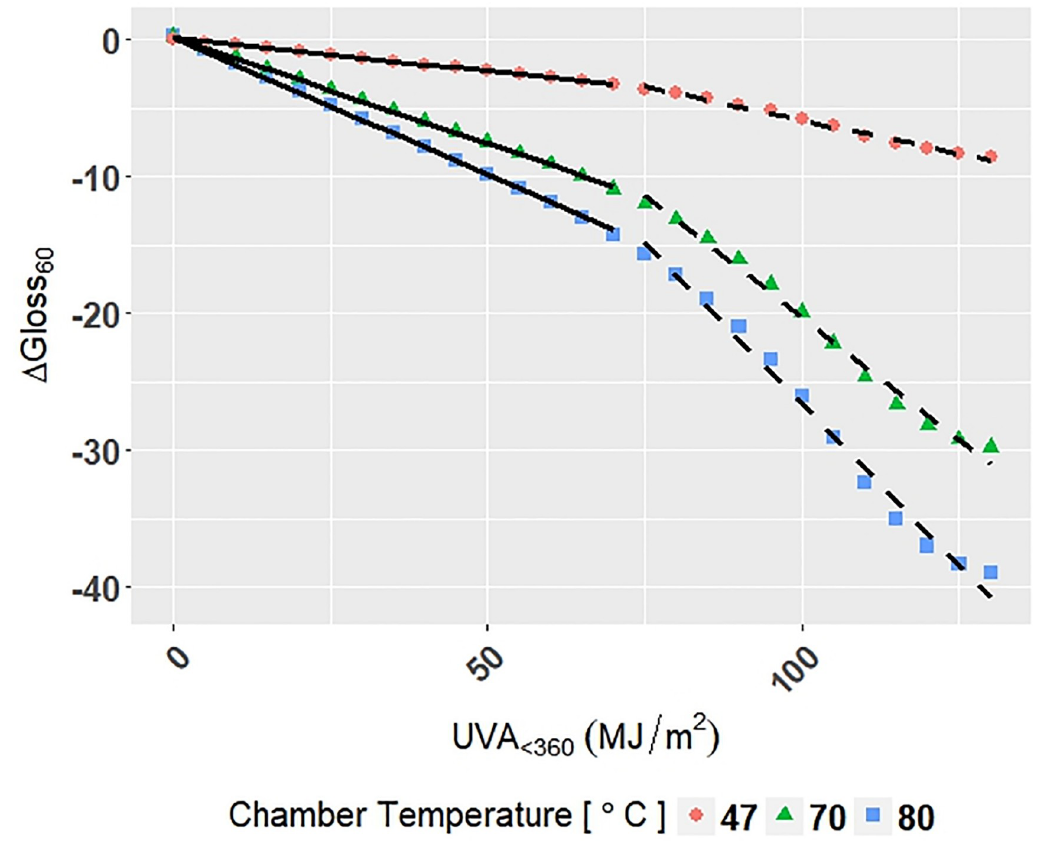
Fig 11. The change in Δ Gloss 60 for the C3 grade of PET under Dry-FS accelerated exposure conditions with the Arrhenius models superimposed on the data. Points represent the measured data, the solid line represents the Arrhenius model for Section 1, and the solid and dashed line represents the Arrhenius model for Section